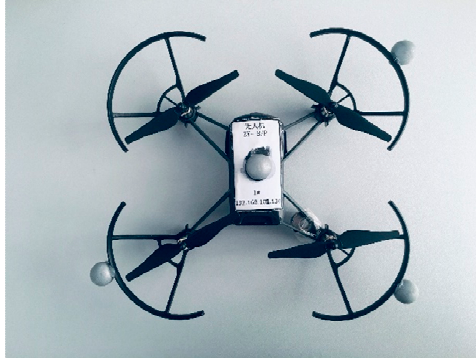
Figure 7. Experimental ZY-B/P type quadrotor.